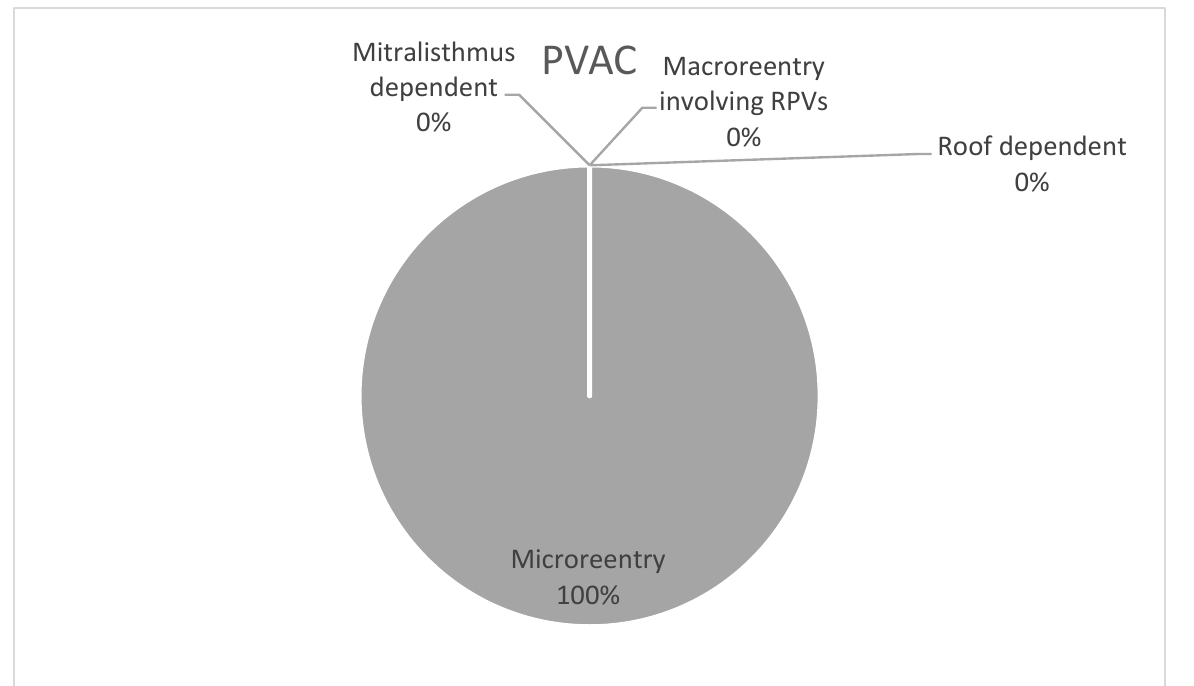
Figure 1. Mechanisms of LAT following PVI (RPV: right pulmonary veins).